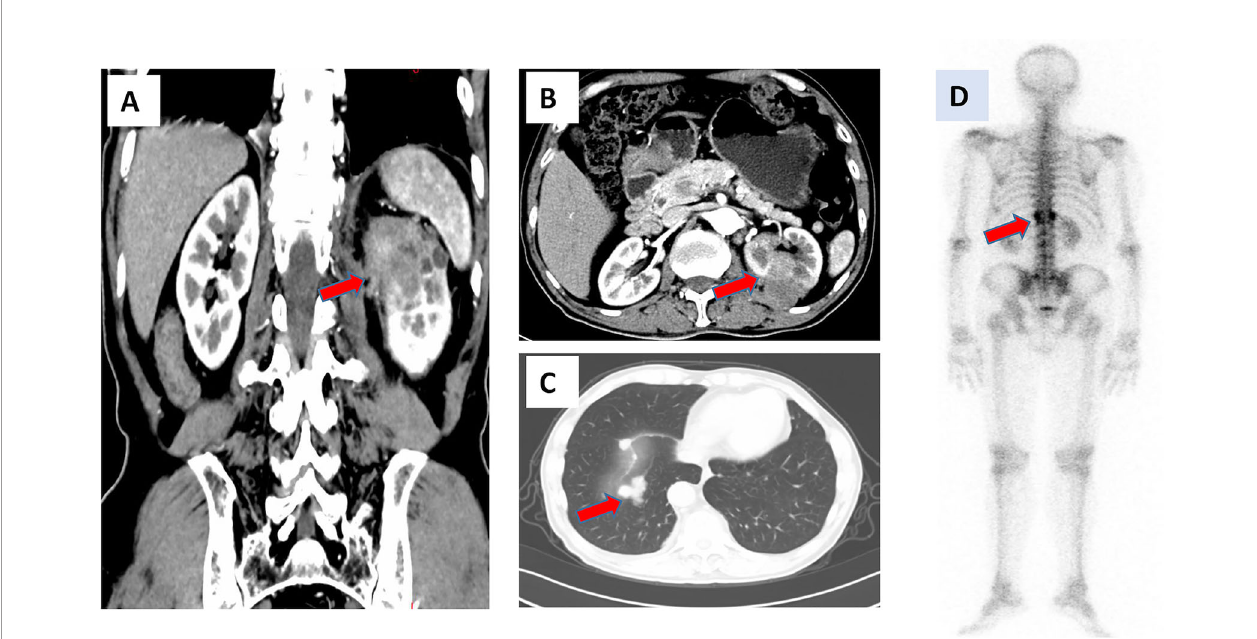
FIGURE 1 | Radiological examination at initial visit. (A, B) Contrast-enhanced CT scan of the abdomen showing a malignant mass in the left kidney. (C) Chest CT scan showing metastatic nodules in the right lower lung. (D) Whole body bone scan showing abnormal T12 vertebration. CT, computed